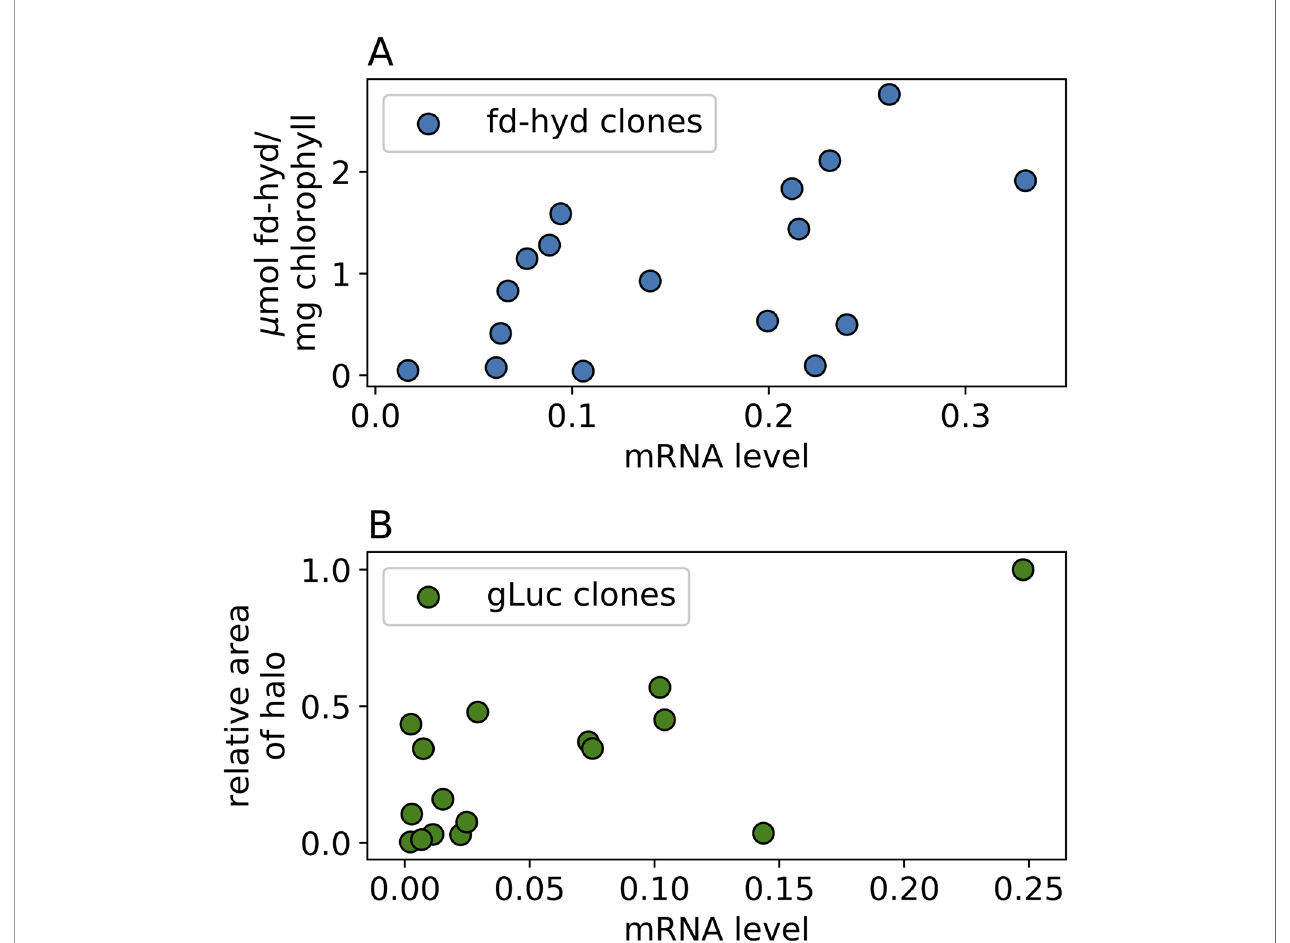
FIGURE 4 | The effect of mRNA levels on protein abundance in the fd-hyd and the gLuc clones. (A) the fd-hyd protein activity was measured using MV. The values are m mol fd − hyd X 10 6 (B) gLuc protein values were calculated using CFQuant's “ Area ” value normalized to the colony size (Dafni et al., 2019). Pearson rhos are 0.55, mg chlorophyll p = 0.023 and 0.69, p = 0.003 for the fd-hyd and the gLuc clones, respectively. All values show mean of three biological